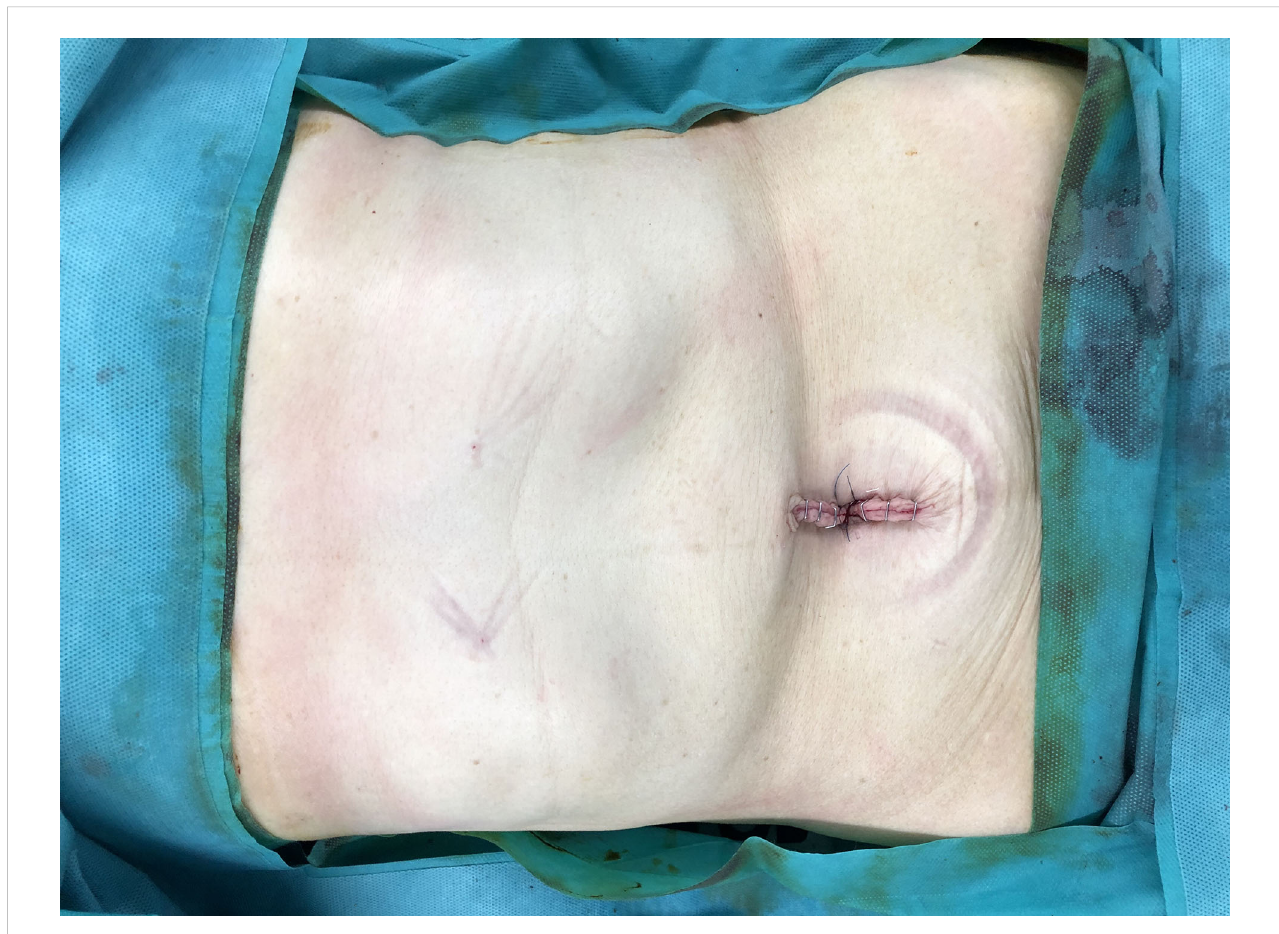
FIGURE 3 The postoperative wound. There was only one trans-umbilical wound in the